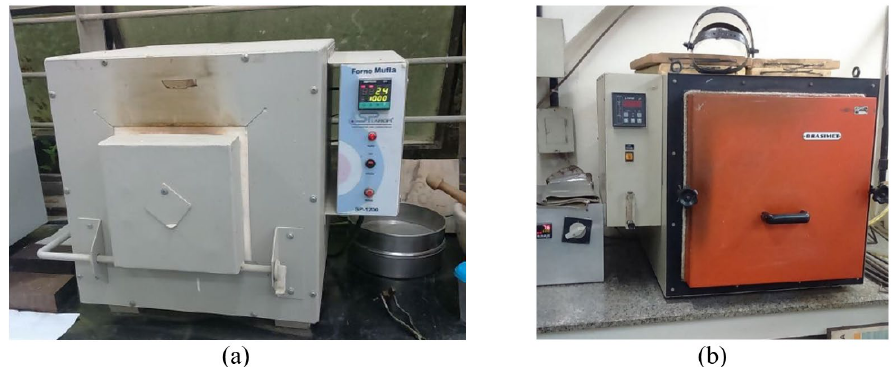
Figure 1. Eletric furnaces used in the experimental program: a) Stage I; b) Stage II.